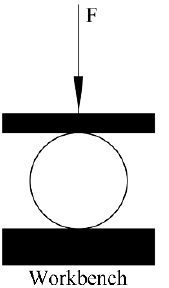
Figure 3. Diagram of the test compression.